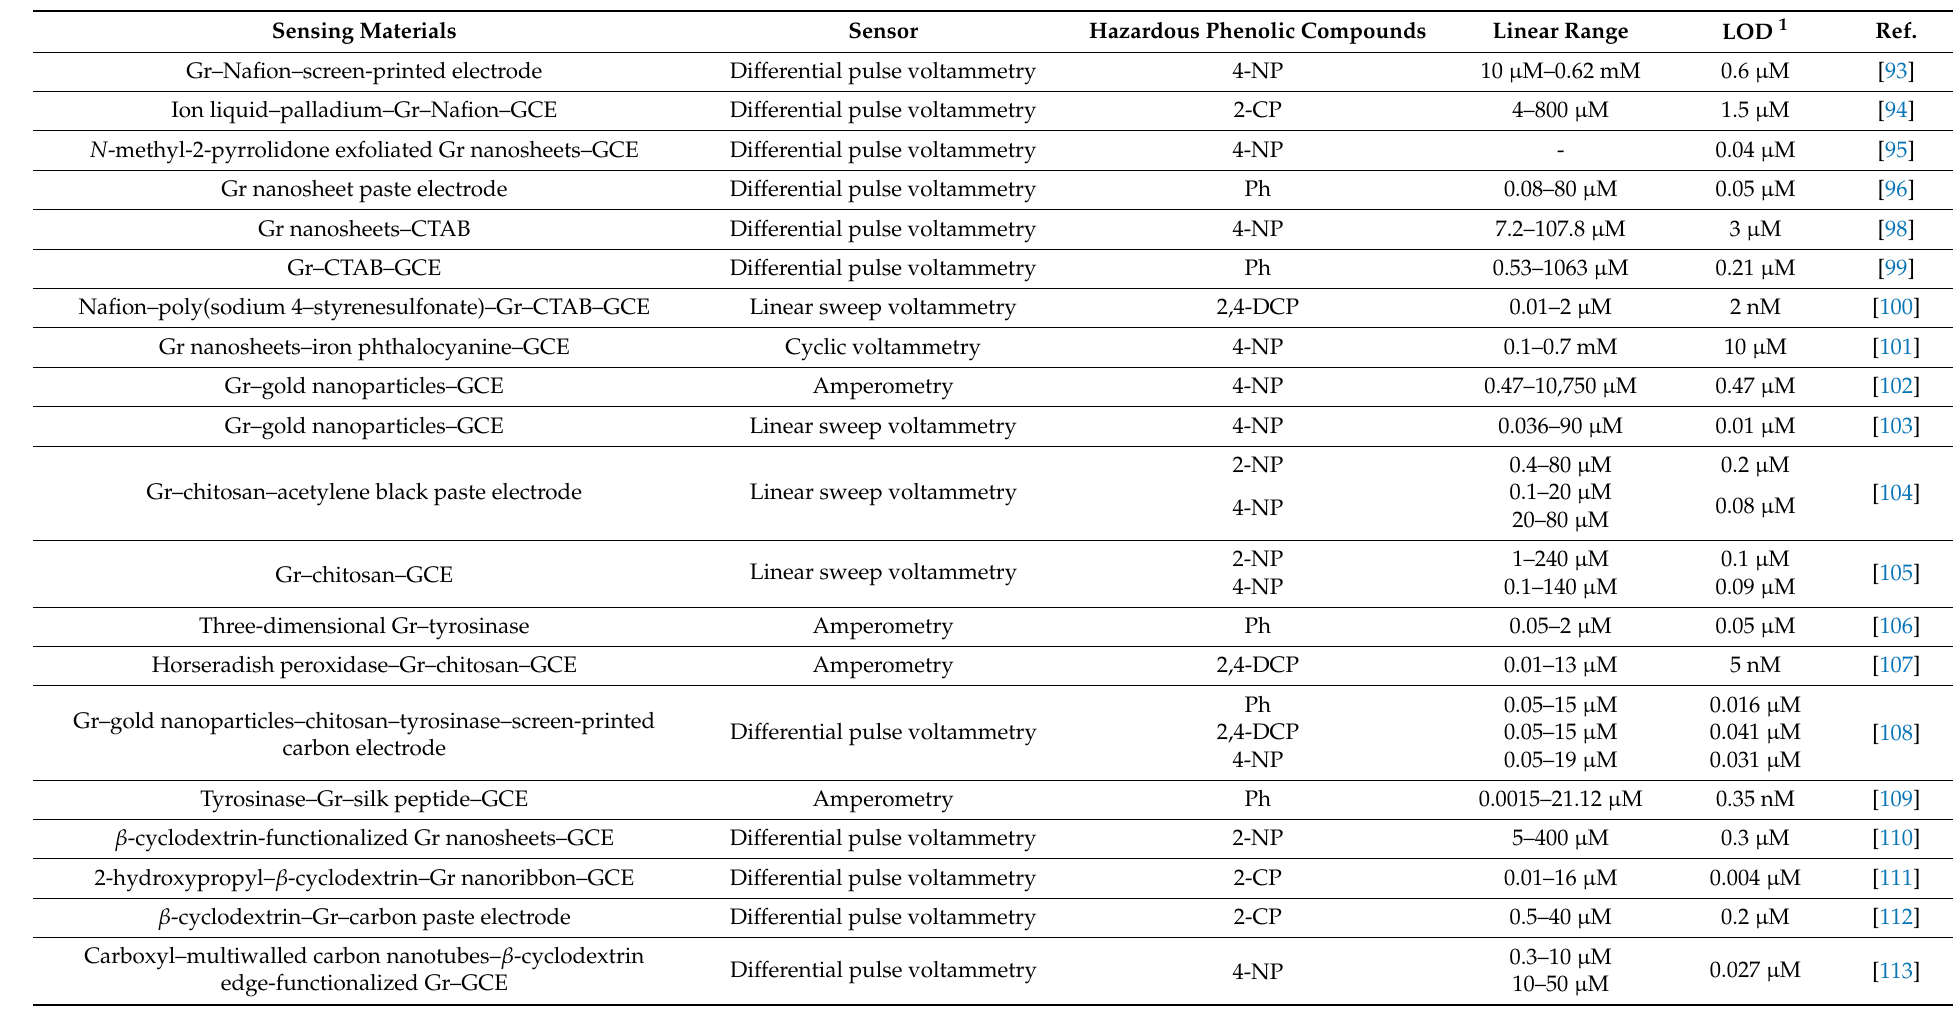
Table 2. Gr-based materials incorporated with electrochemical sensors for hazardous phenolic compounds